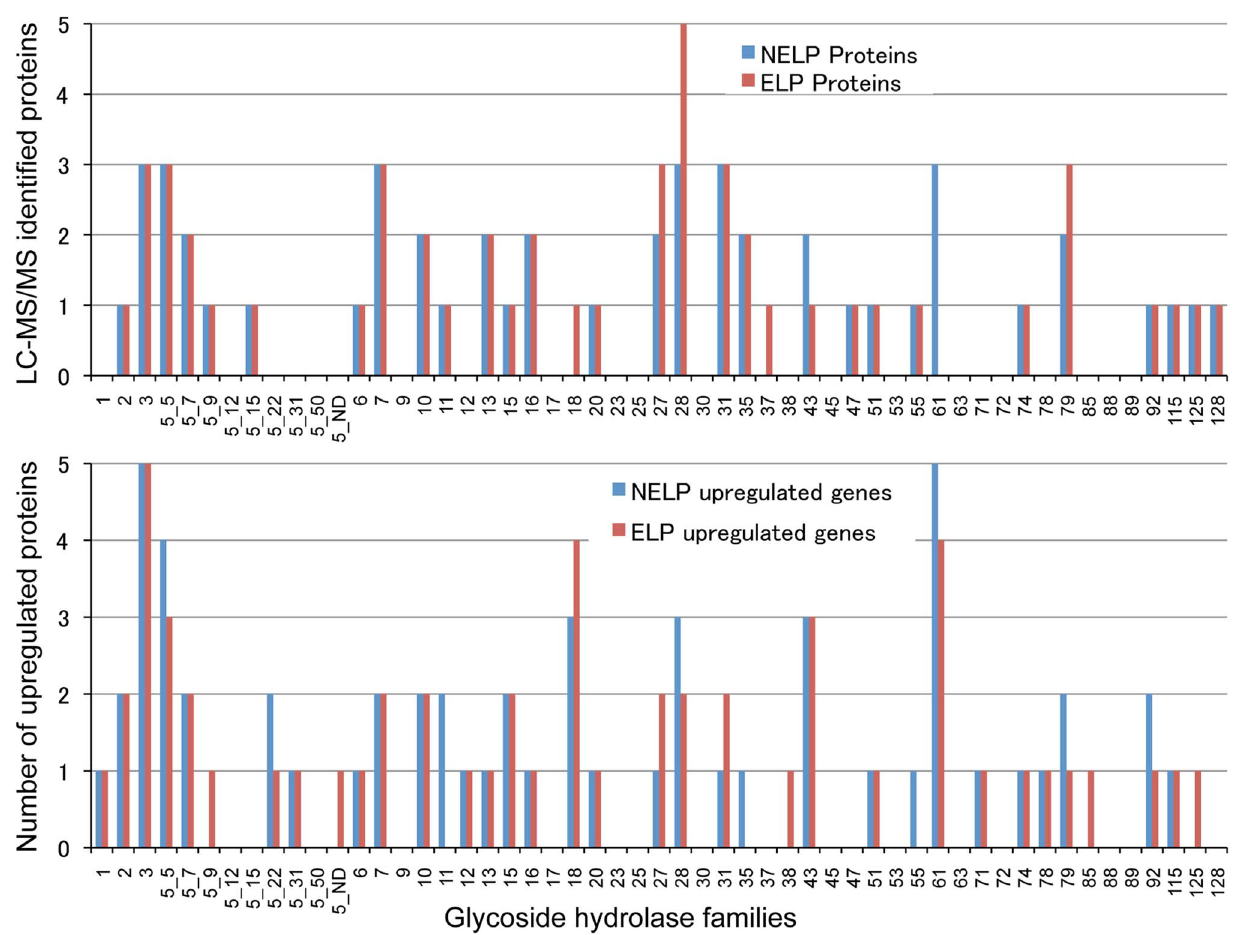
Figure 8. Glycoside hydrolase encoding genes show similar patterns of expression in media containing freshly ground and non- extracted loblolly pine wood (NELP) relative to the same substrate but extracted with acetone (ELP) to remove pitch and resins. Proteins (upper panel) and transcripts (lower panel) were identified by LC-MS/MS and RNA-seq, respectively. Protein identification was limited to those with . 2 unique peptides after five days incubation. Transcript upregulation was limited to significant accumulation (p , 0.05; . 2-fold) on NELP or ELP relative to glucose-containing medium. Secretome and transcriptome experimental details and complete data are presented in Text S1 and Dataset